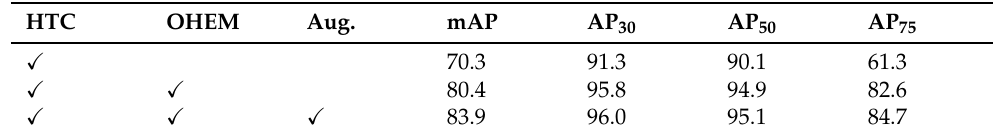
Table 4. Beading detection ablation